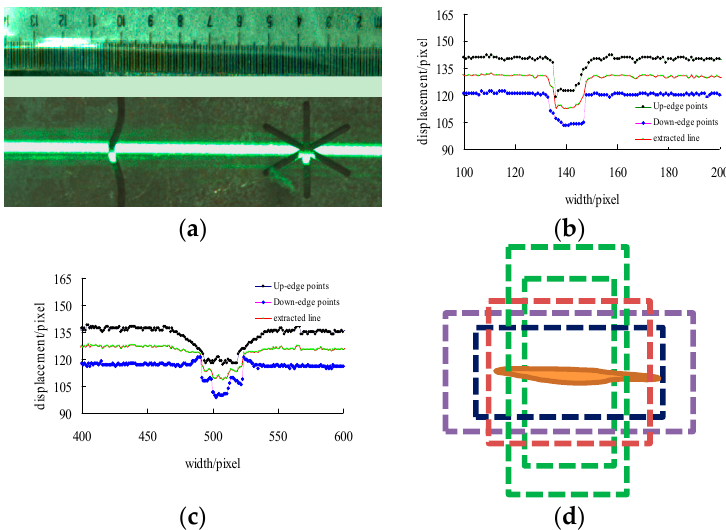
Figure 12. The candidate ROI location in different areas. ( a ) The testing sample defects; ( b ) ROI location in linear defect; ( c ) ROI extraction in star defect; ( d ) The candidate bounding box.